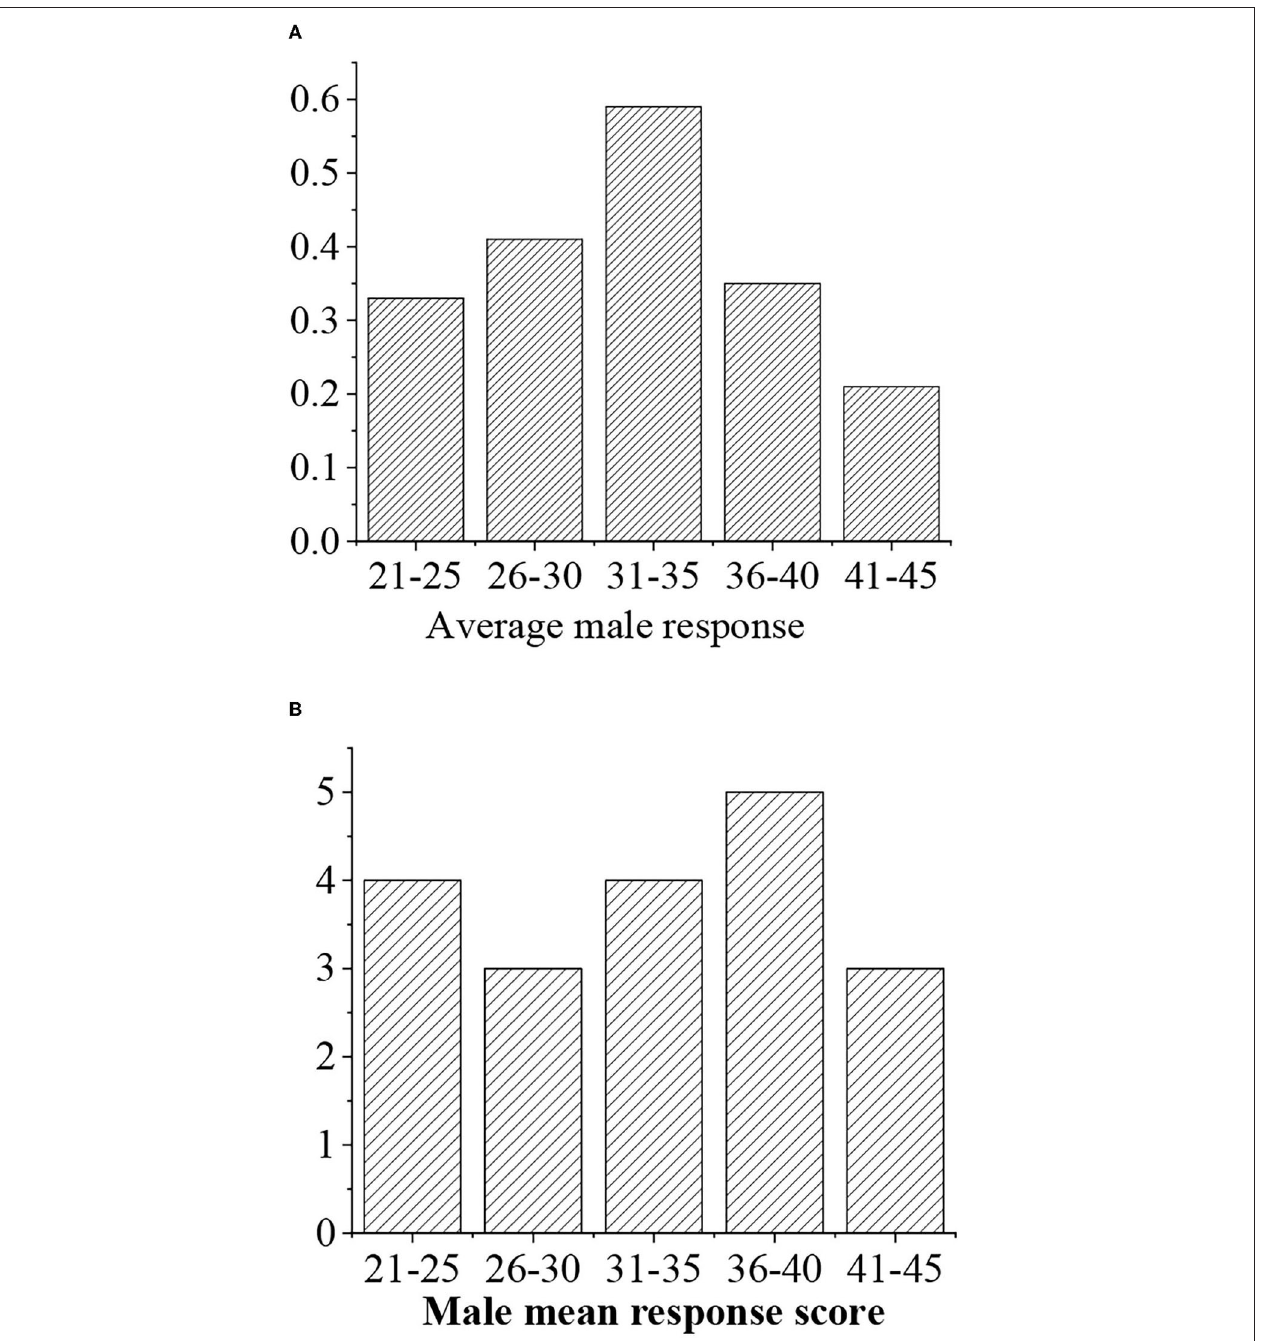
FIGURE 8 | (A) Statistical average response value for men of different ages. (B) Response value